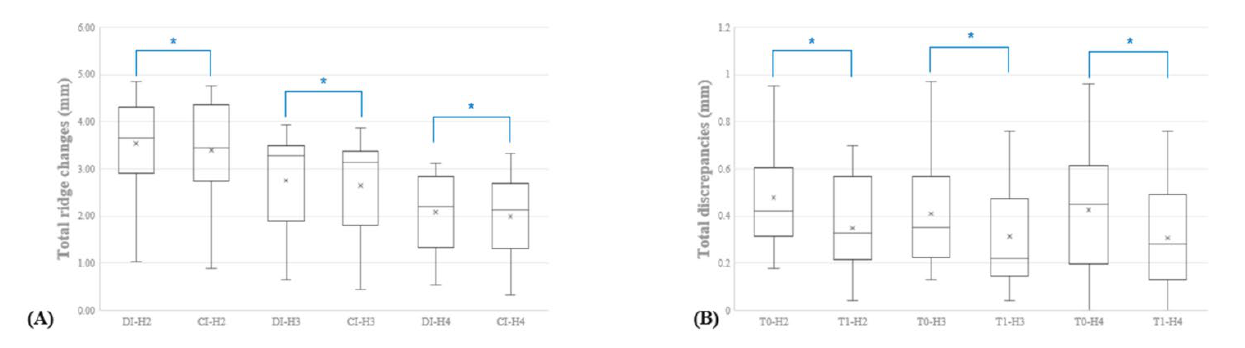
Figure 3. Box plots represent the discrepancies between the ridge changes measured in groups DI and CI and between the time-wise intergroup differences. ( A ) Total ridge changes in groups DI and CI, ( B ) difference between the groups at T0 and T1. H2: 2 mm below the ridge crest, H3: 3 mm below the ridge crest, H4: 4 mm below the ridge crest, T0: immediately after tooth extraction, T1: at 2 months after extraction, group CI: conventional impression using vinyl polysiloxane impression material, group DI: digital impression using an intraoral scanner, * p < 0.05.